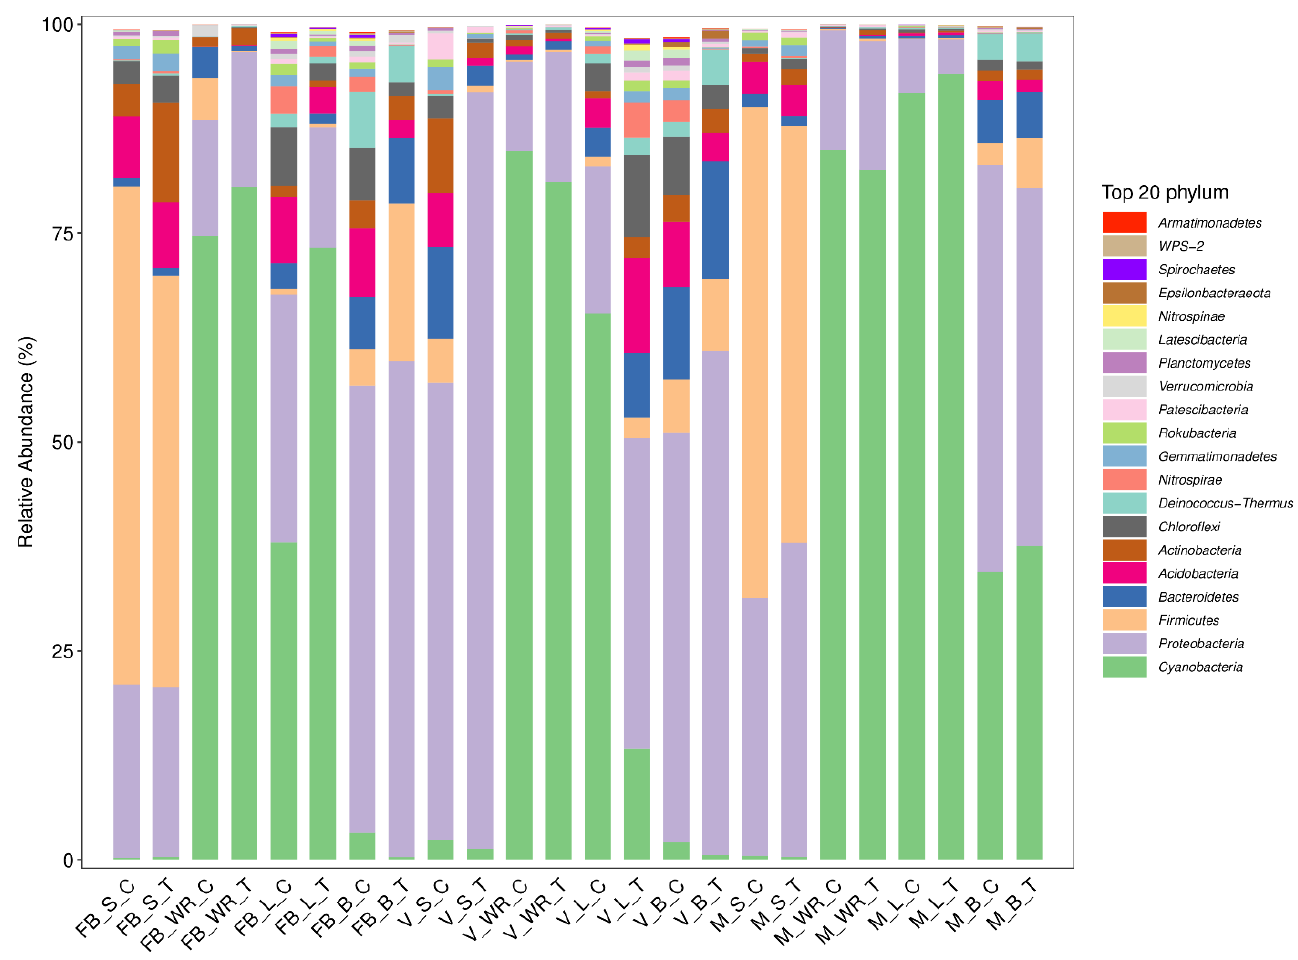
Figure 1. Relative abundance (%) of the significant bacterial phyla existing in rhizosphere soil (S), white roots (WR), leaves (L) and berries (B) at three phonological stages as full bloom (FB), veraison (V), and maturity (M). Root-zone-restricted plants are denoted as treatment (T) while control plants as (C).